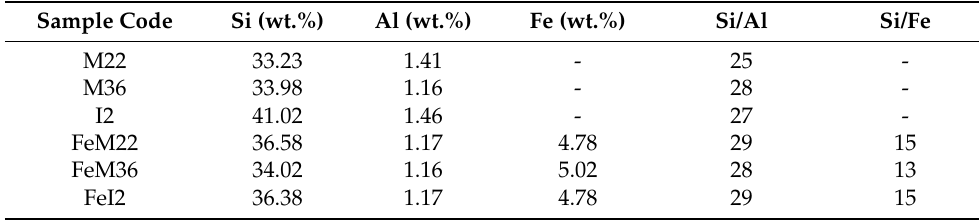
Table 1. The content of Si, Al, and Fe with the corresponding Si/Al and Si/Fe molar ratios in the non-non modified zeolites and the